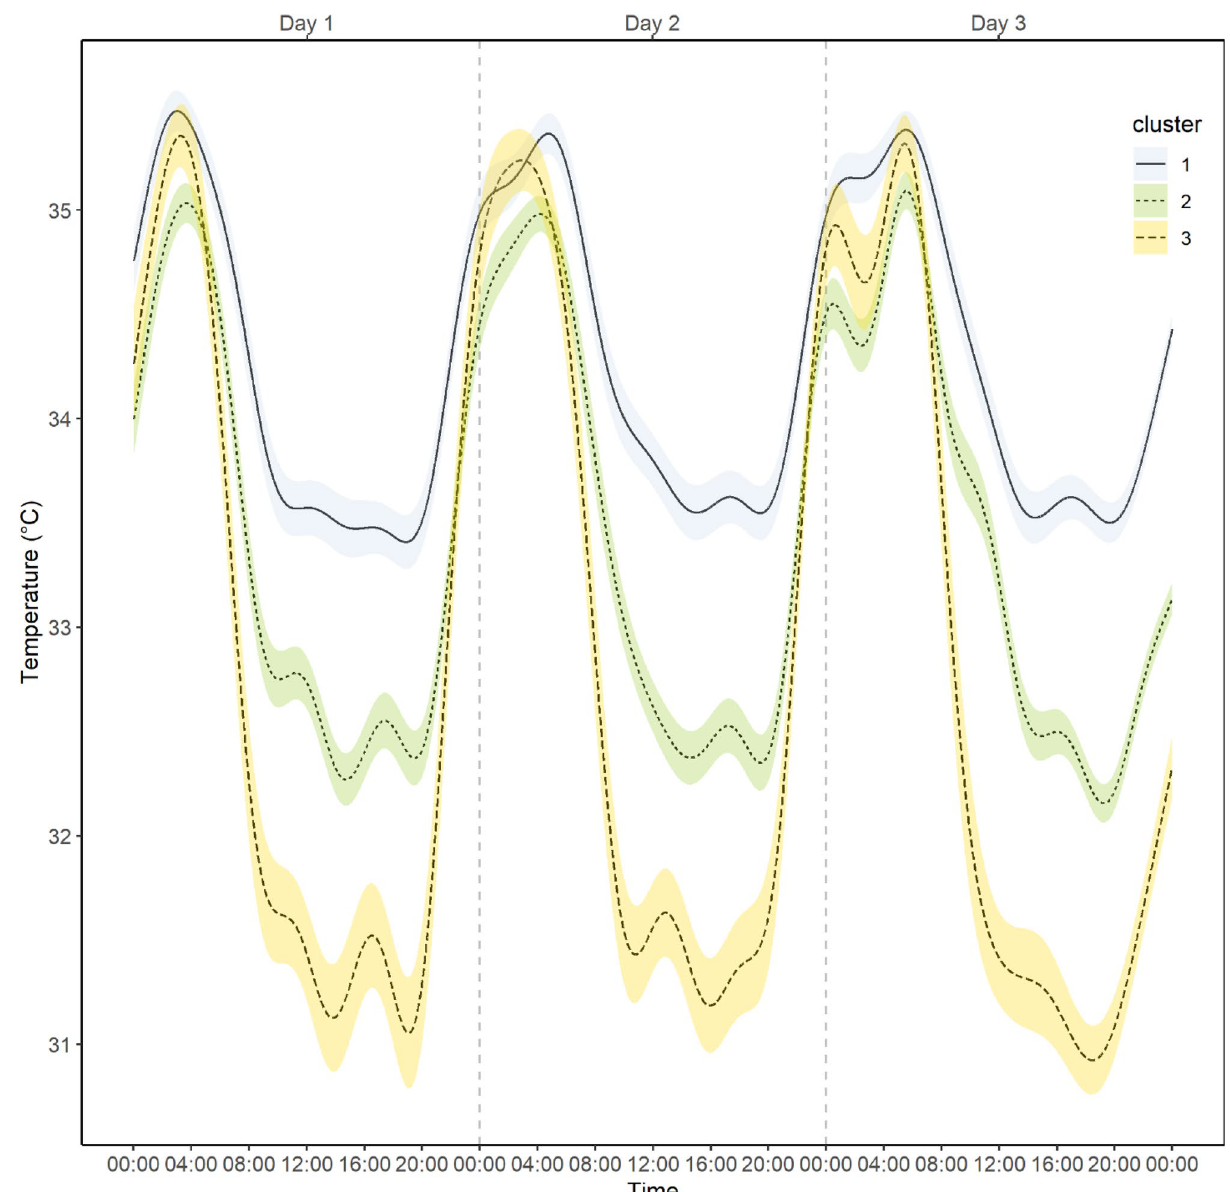
Figure 3. Cluster means and confidence intervals of the circadian temperature clusters based on original temperature measures. Confidence intervals: ± 1 standard error. Figure produced using R Core Team (2021). R: A language and environment for statistical computing. R Foundation for Statistical Computing, Vienna, Austria. https:// www.R- proje ct.